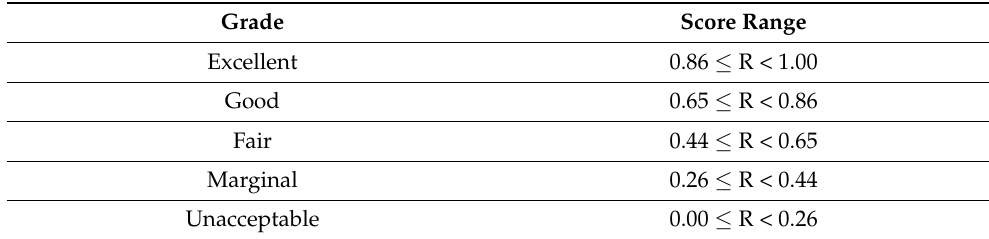
Table 2. Grades of the CORA